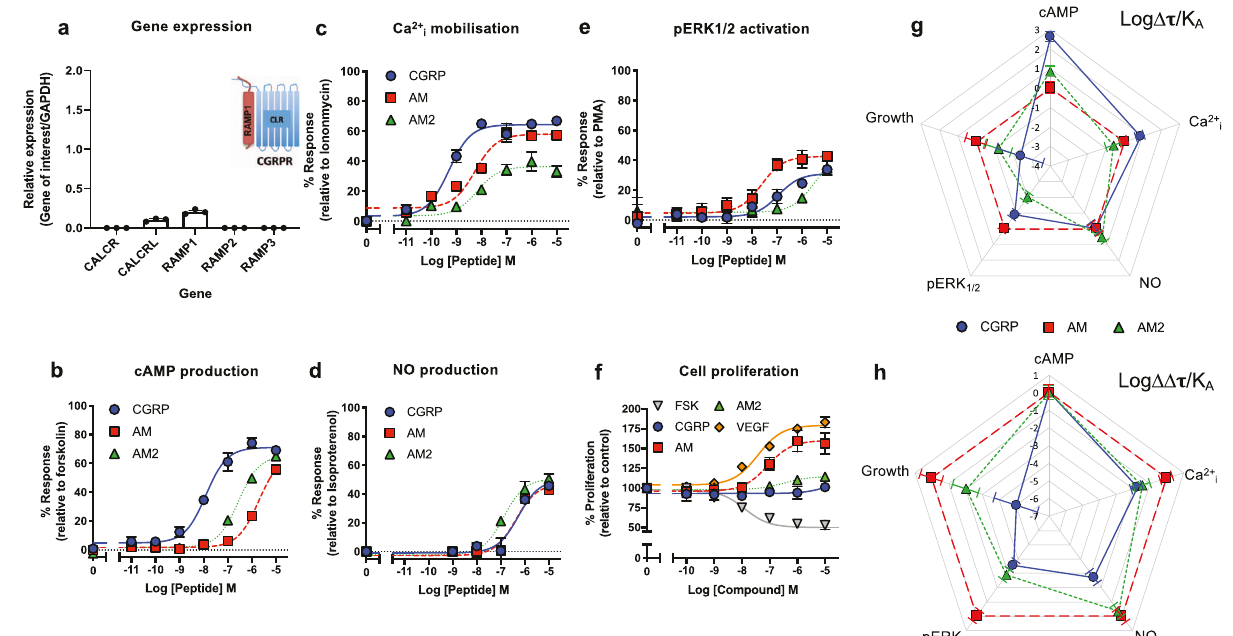
Fig. 4 CGRP family peptide signalling bias in human cardiomyocytes. a Expression of CALCR, CALCRL , RAMP1 , RAMP2 , and RAMP3 genes in HCMs. Data normalised to GAPDH expression. n = 3 independent experiments. b – f Dose – response curves were constructed for HCMs stimulated with CGRP, AM or AM2 and the cAMP levels quanti fi ed relative to forskolin (100 μ M) ( n = 6) ( b ), mobilisation of Ca 2 + i relative to ionomycin (10 μ M) ( n = 4) ( c ), total NO production relative to isoproterenol (10 μ M) ( n = 3) ( d ), intracellular ERK 1/2 phosphorylation relative to PMA (10 μ M) ( n = 4) ( e ) and extent of cell proliferation (after 72 h) relative to vector treated control and VEGF ( n = 5) ( f ). Data are analysed using a three-parameter non-linear regression curve or the operational model of receptor agonism 27 . g , h Signalling bias plots were calculated as Δ Log( τ /K A ) ( g ) or ΔΔ Log( τ /K A ) ( h ) for each agonist and for each signalling pathway. Determination of values requires normalisation to a reference agonist (AM) alone in ( g ), while for ( h ) values were normalised to both a reference agonist (AM) and a reference pathway (cAMP). All data represent mean ± SEM for n